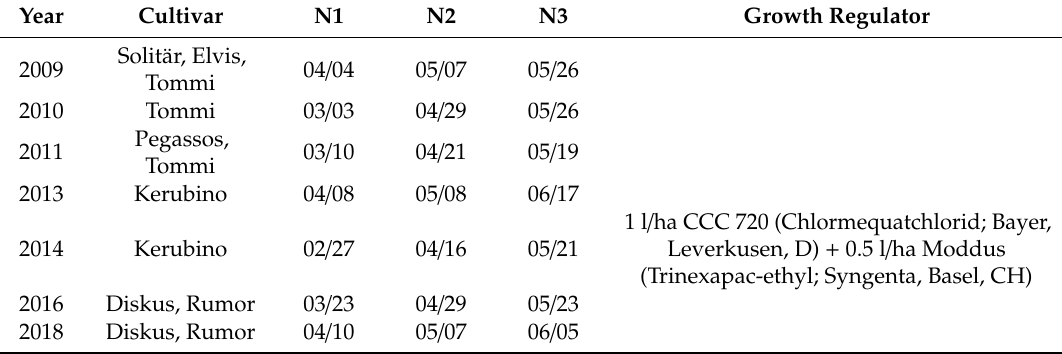
Table 1. Overview on field trials by years: Cultivars, dates (month / day) for three doses of N fertilization and growth regulator treatment in